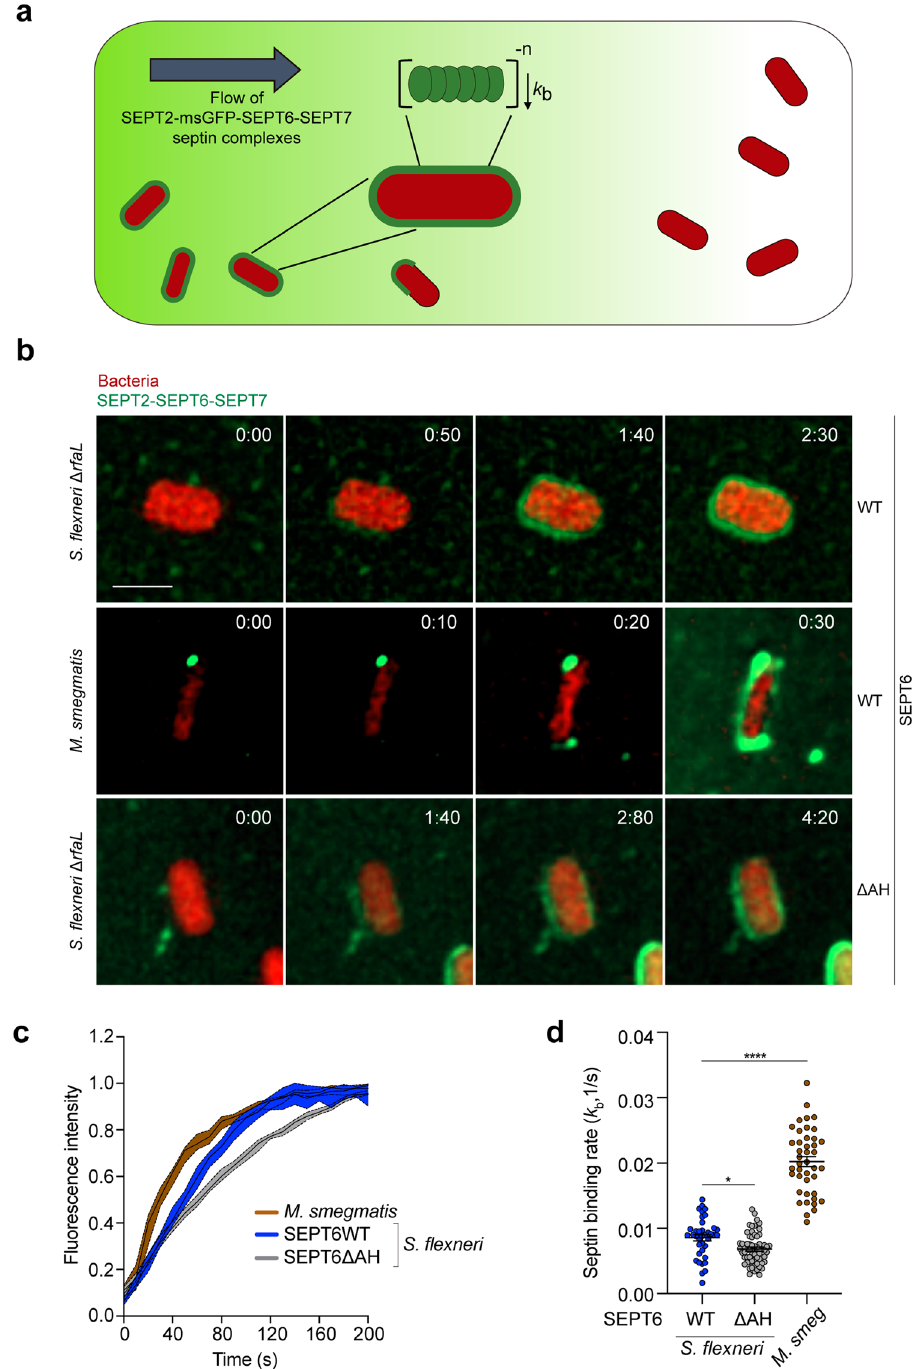
Fig. 5 The kinetics of septin binding depends on bacterial species and the amphipathic helix domain of SEPT6. a Scheme showing the protocol followed to calculate the binding rates of SEPT2 – msGFP-SEPT6 – SEPT7 septin complexes (green) to bacteria using micro fl uidics and fl uorescence microscopy. b Representative time-lapse fl uorescence microscopy showing the entrapment of S. fl exneri Δ rfaL producing cytosolic mCherry (msGFP-SEPT6WT- complexes, top panel; msGFP-SEPT6 Δ AH-complexes, bottom panel) and M. smegmatis (msGFP-SEPT6WT-complexes, middle panel) in septin cages (green) in vitro. Time is showed as min:s (top right corner). This experiment was performed 2 independent times. Scale bar, 2 μ m. c Mean msGFP – SEPT6 intensity per cell over time showing binding of septin complexes to S. fl exneri Δ rfaL mCherry (blue line, msGFP-SEPT6WT; gray line, msGFP-SEPT6 Δ AH) and M. smegmatis DsRed (brown line). Mean intensity values are normalized by maximum intensity observed in each cell for visualization purposes. Data represent the median± 95% con fi dent interval of n = 38 ( S. fl exneri Δ rfaL + msGFP-SEPT6WT), n = 60 ( S. fl exneri Δ rfaL + msGFP-SEPT6 Δ AH), and n = 42 ( M. smegmatis ) cells distributed in 2 independent experiments. d Extracted binding rates ( k b ) of septin complexes to S. fl exneri Δ rfaL mCherry and M. smegmatis DsRed in full septin cages in vitro. Data represent the mean ± SEM of n = 38 ( S. fl exneri Δ rfaL + msGFP-SEPT6WT), n = 60 ( S. fl exneri Δ rfaL + msGFP-SEPT6 Δ AH), and n = 42 ( M. smegmatis + msGFP-SEPT6WT) cells distributed in 2 independent experiments. * p = 0.0338, **** p < 0.0001 by one- way ANOVA and Dunnett ’ s post-test.